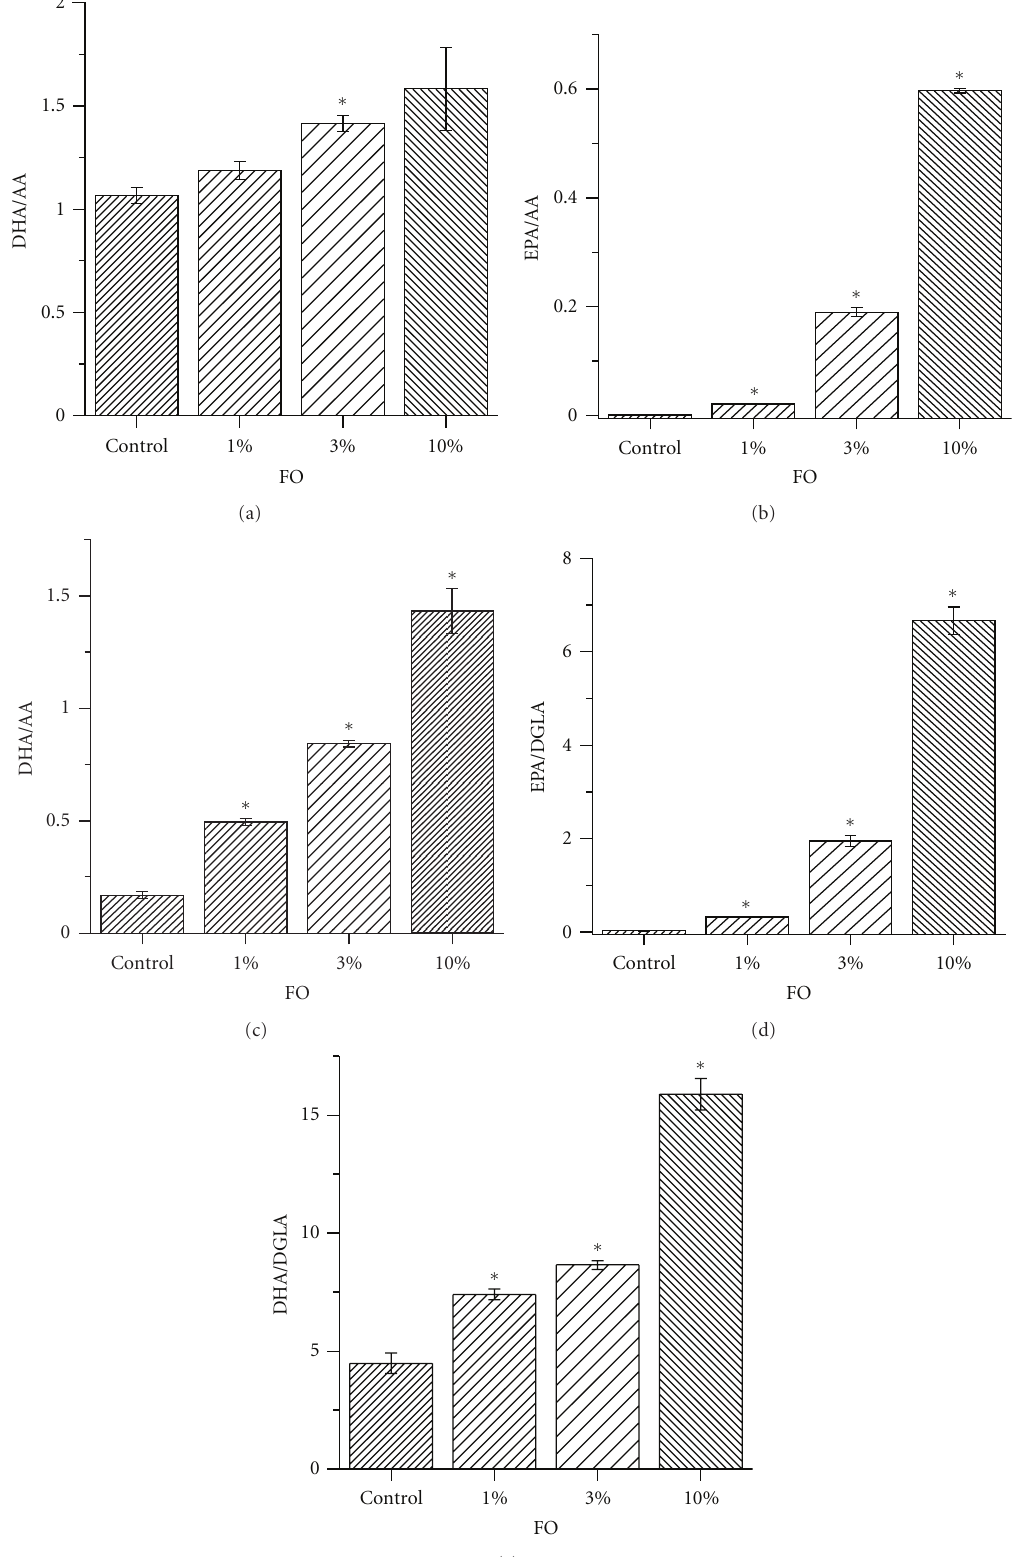
Figure 2: E ff ect of dietary FO on mitochondrial ratio of EPA, DHA, AA, and DGLA. (a) Changes in nonsynaptosomal brain mitochondria fatty acids; (b–e) Changes in liver mitochondria. Data are expressed as means of group of n = 3–5, ± SEM. Statistical significance between tested samples was determined by a two-sample t -test, level of significance was set at P < 0 .